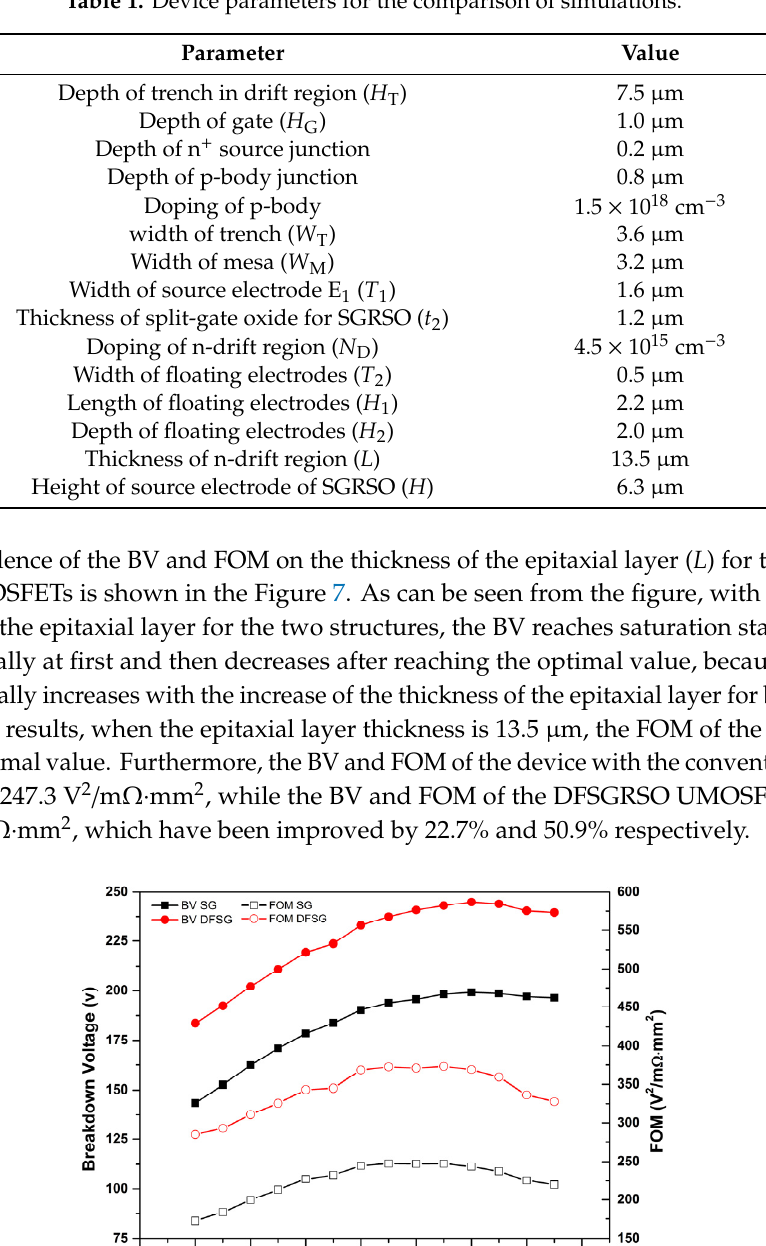
Table 1. Device parameters for the comparison of simulations.